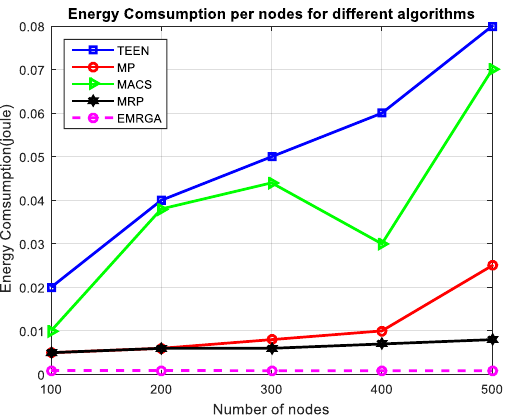
Figure 10. Energy consumption.